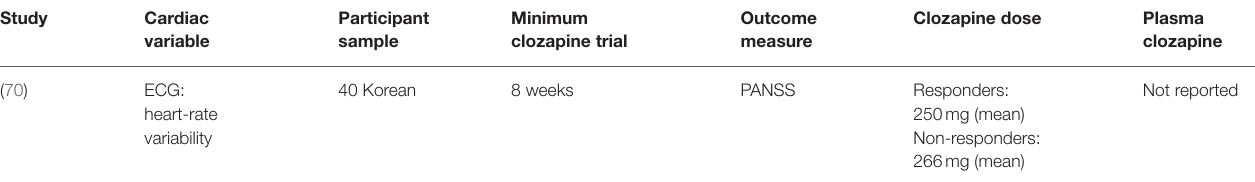
TABLE 6 | Included cardiac studies.